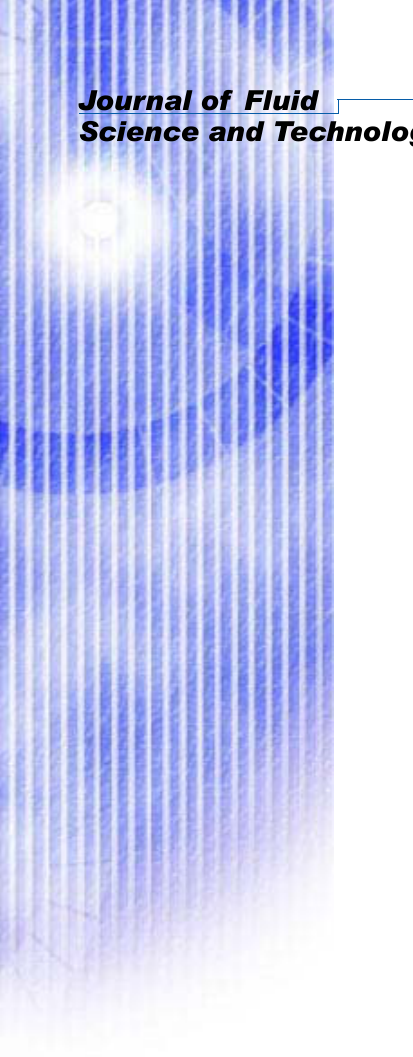
Fig.9 Distributions of )( y θ along av the y axis , without oscillation)